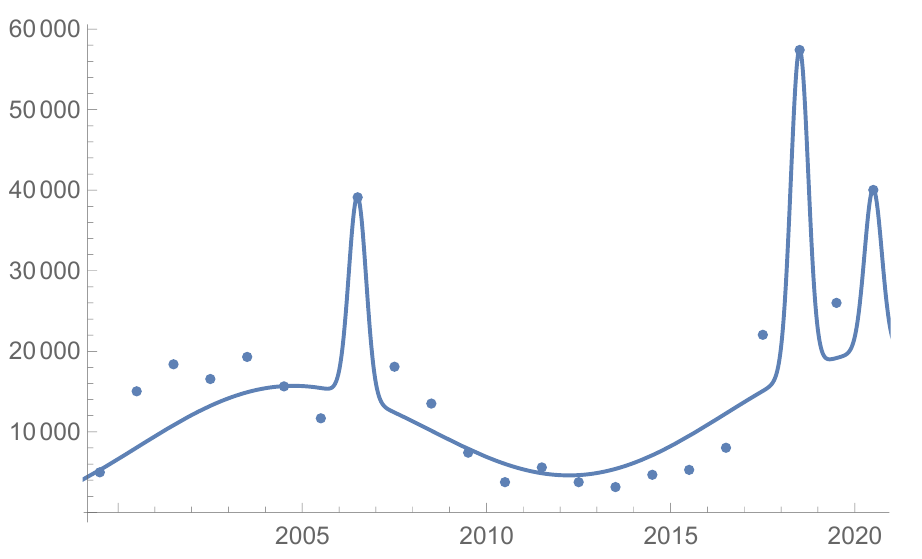
Figure 1. Incoming irregular immigration.